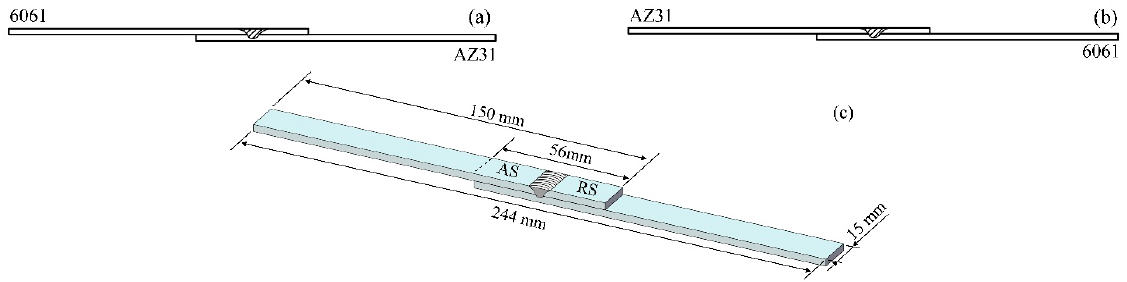
Figure 1. Schematic of lap joint modes: ( a ) Al-Mg and ( b ) Mg-Al configurations and ( c ) dimensions of the tensile shear specimen.